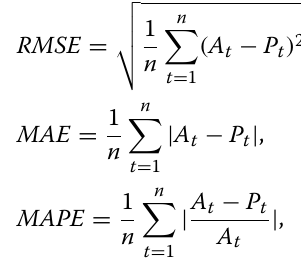
Fig. 11 Predictions and actual price of the 50ETF over time. Note: This graph depicts the time series of the predicted and realized values from Feb 2011 to October 2021. The orange line is the predicted value of the GRU model for a total of 80 time